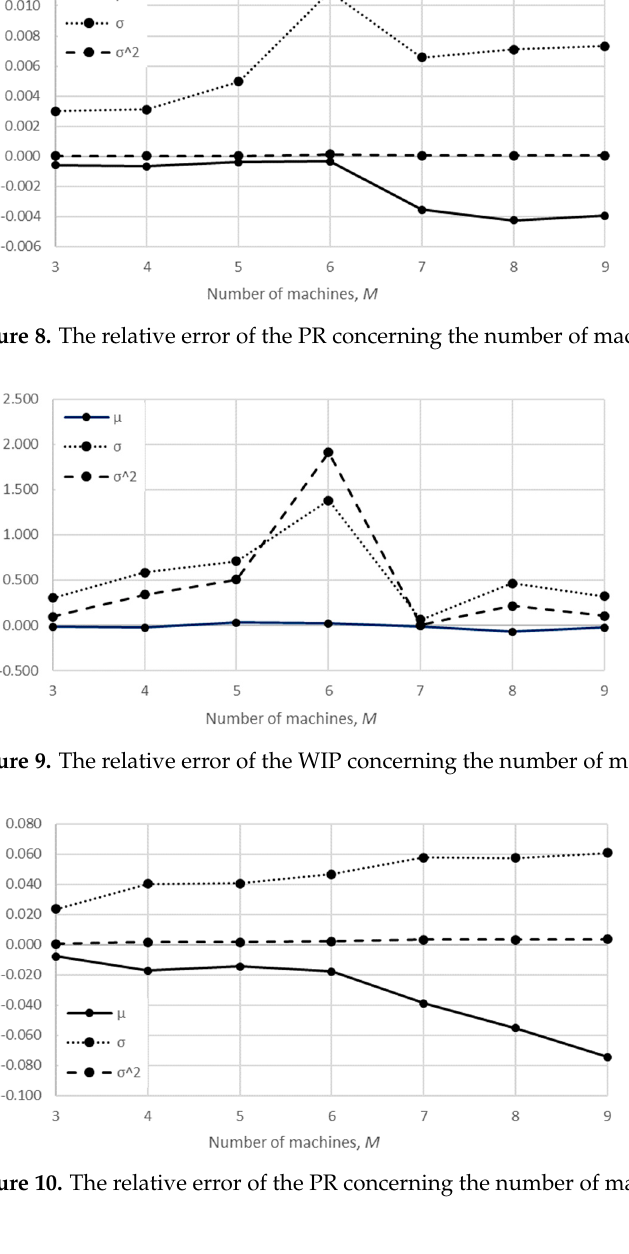
Figure 11. The relative error of the WIP concerning the number of machines—FSM.